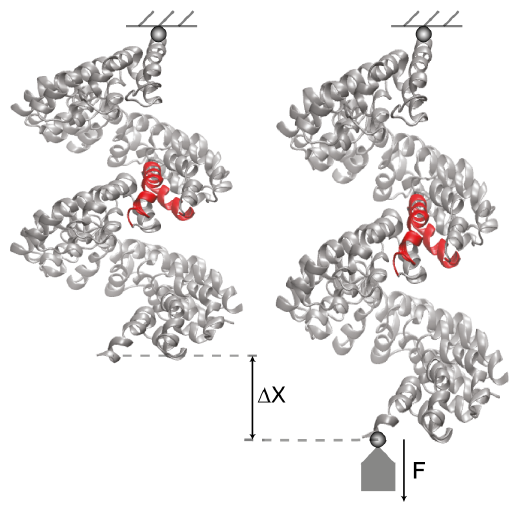
Figure 1. Schematic illustration of the in silico force-probe experiments. Exemplarily, the PthXo1 TAL effector is shown in ribbon representation with one end being immobilised and the other end exerted to a force caused by a fictitious weight applied. One selected TAL repeat is shown in red colour.